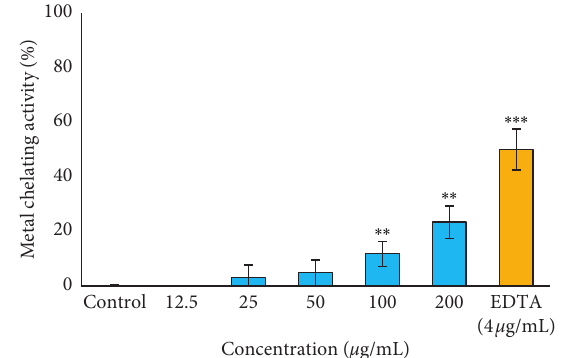
Figure 2: Inhibitory effect of the ethanol extract of B. asphodeloides on metal ion chelating activity. Data are presented as the mean ± SD ( n � 3). ∗ ∗ P < 0 . 01 and ∗∗ ∗ P < 0 . 001 compared to the